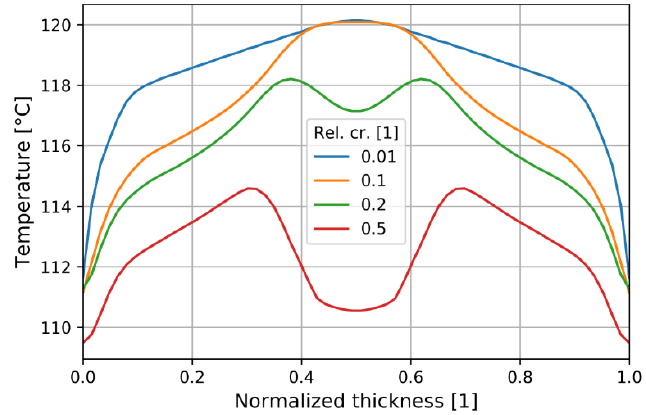
Figure 13. Temperature distribution through normalized thickness depending on relative crystallinity at P2. at P2.